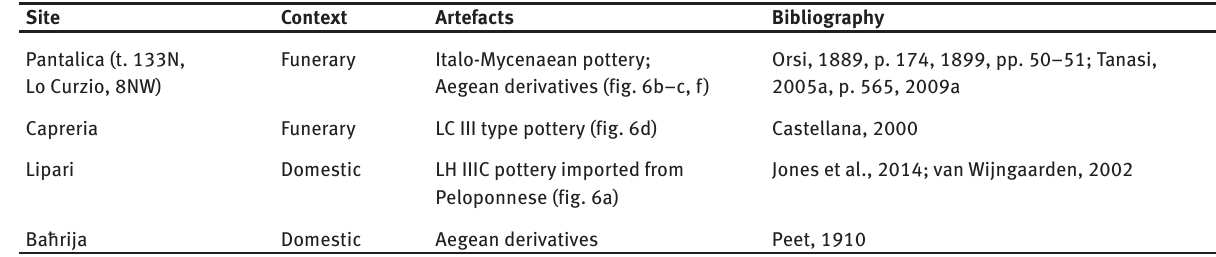
Table 7: Pottery of Mycenaean and Cypriote Origin in Late Bronze Age Sicily.